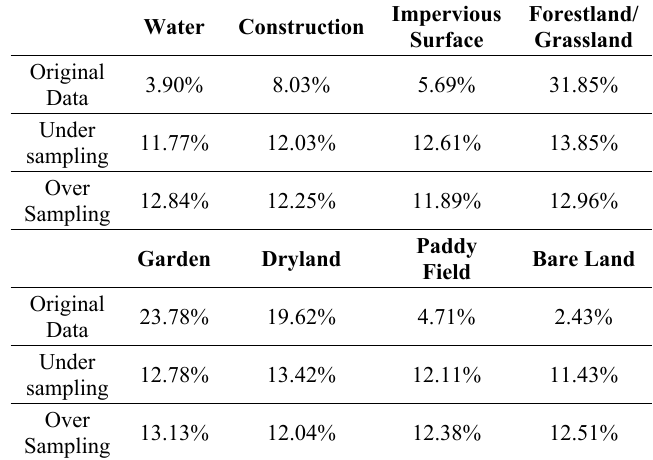
Table 2 Distribution Proportions of Land Types in All